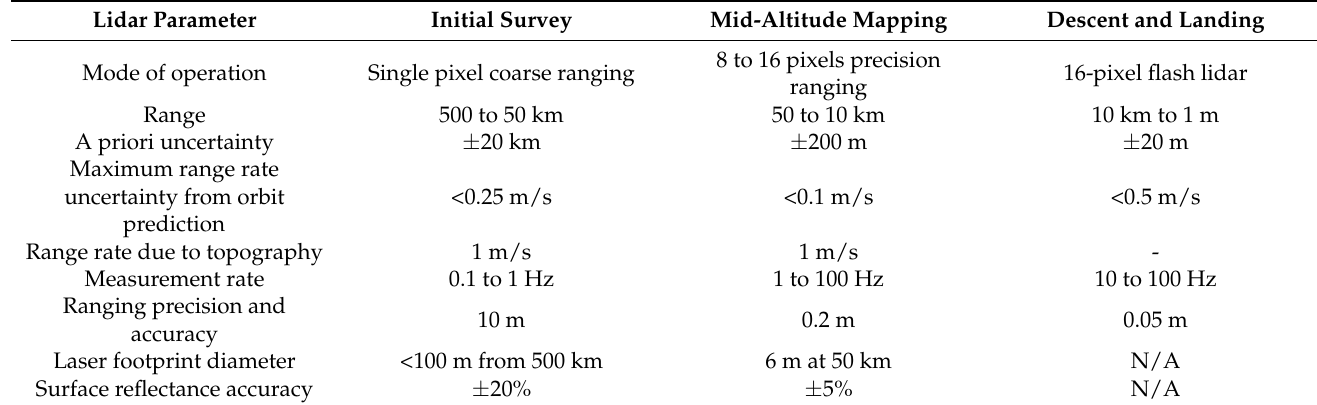
Table 3. SALi operation modes.